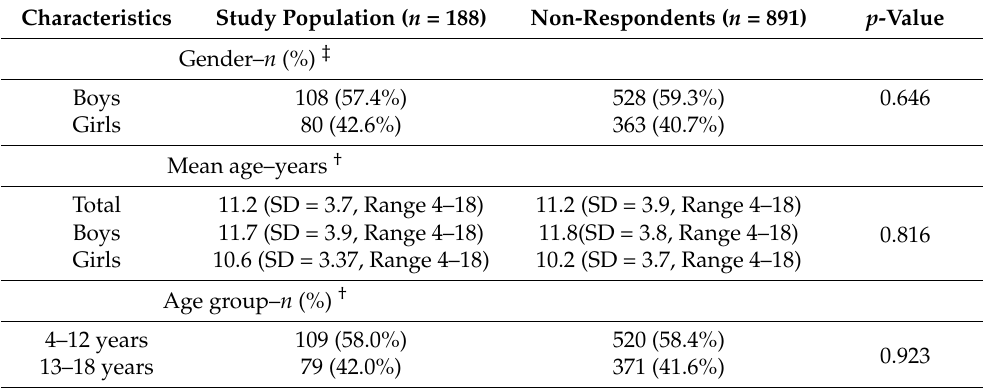
Table 1. Baseline characteristics for included respondents vs.